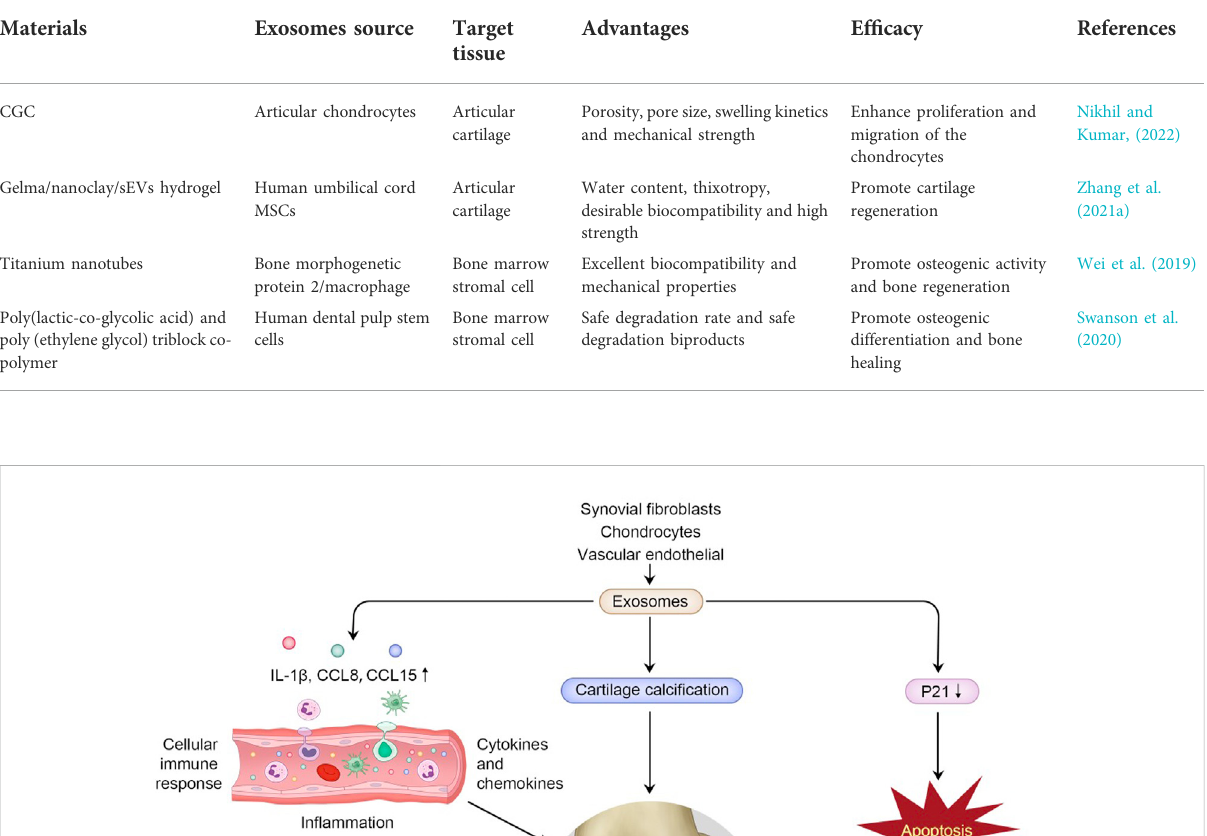
TABLE 3 Exosomes and cartilage tissue engineering.